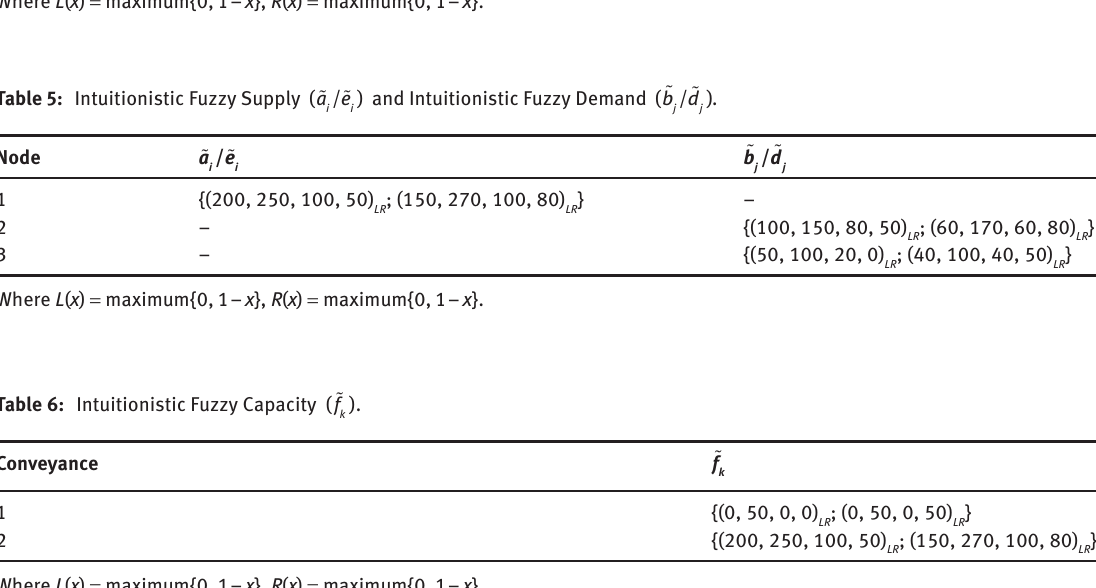
b d (cid:31) (cid:31) j j